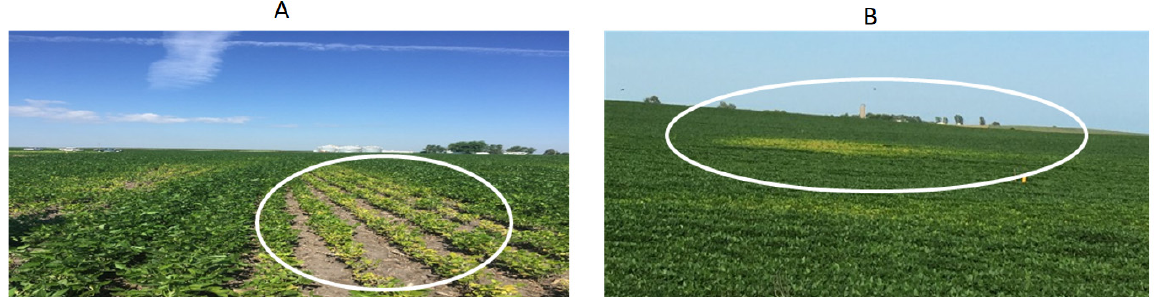
Figure 1. Spatial variation patterns (severity and irregularity) in soybean IDC in commercial production fields. ( A ) IDC oval pattern in the lower/ditch area at Madrid, Iowa, in 2016. ( B ) IDC circle pattern in a farmer’s field at Ames, Iowa, 2016. Field variation patterns are described by variation severity (the degree of autocorrelation in the experiment field) and pattern irregularity (the shape of a spatial pattern).